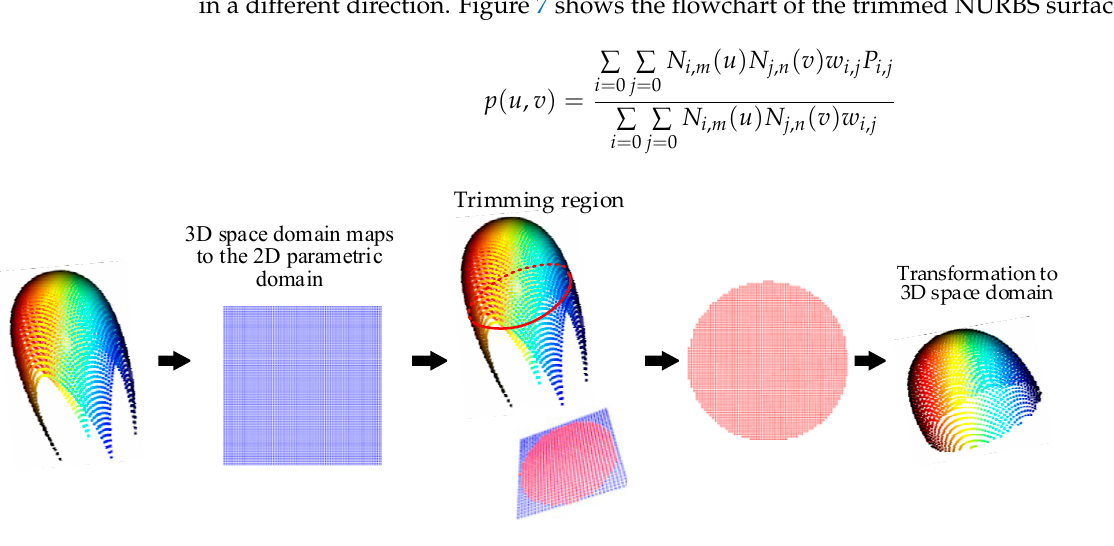
Figure 7. The trim of the curved surface point